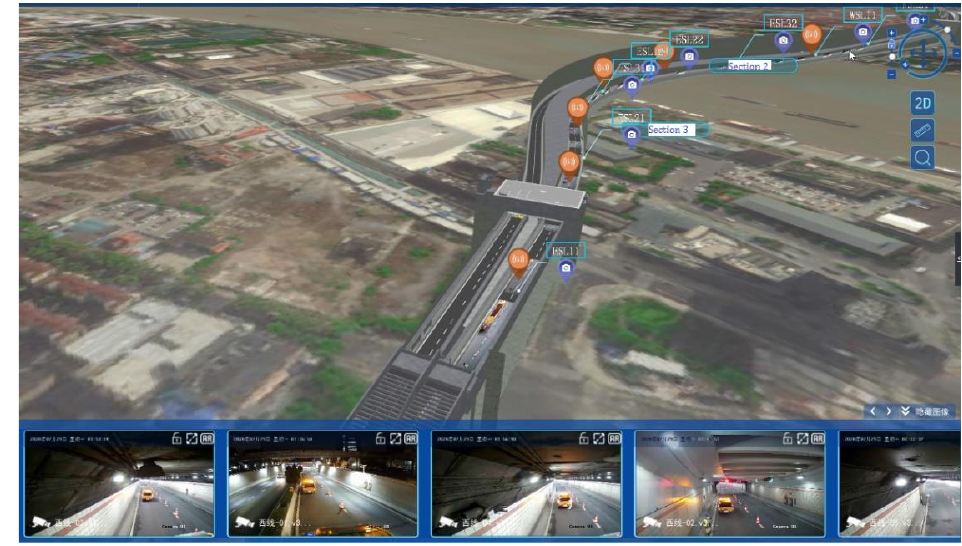
Figure 14. 3D fusion and enhanced display of IoT facilities.